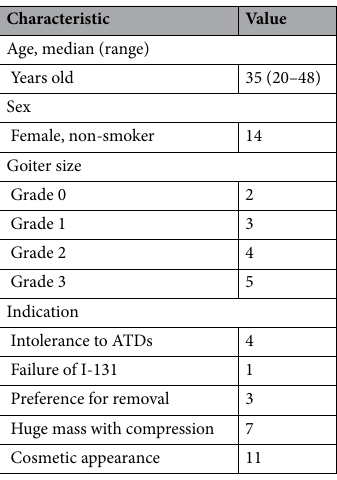
Table 1. Demographics, goiter size, and indications of the patients. Data are presented as the number of patients unless otherwise noted. ATD anti-thyroid